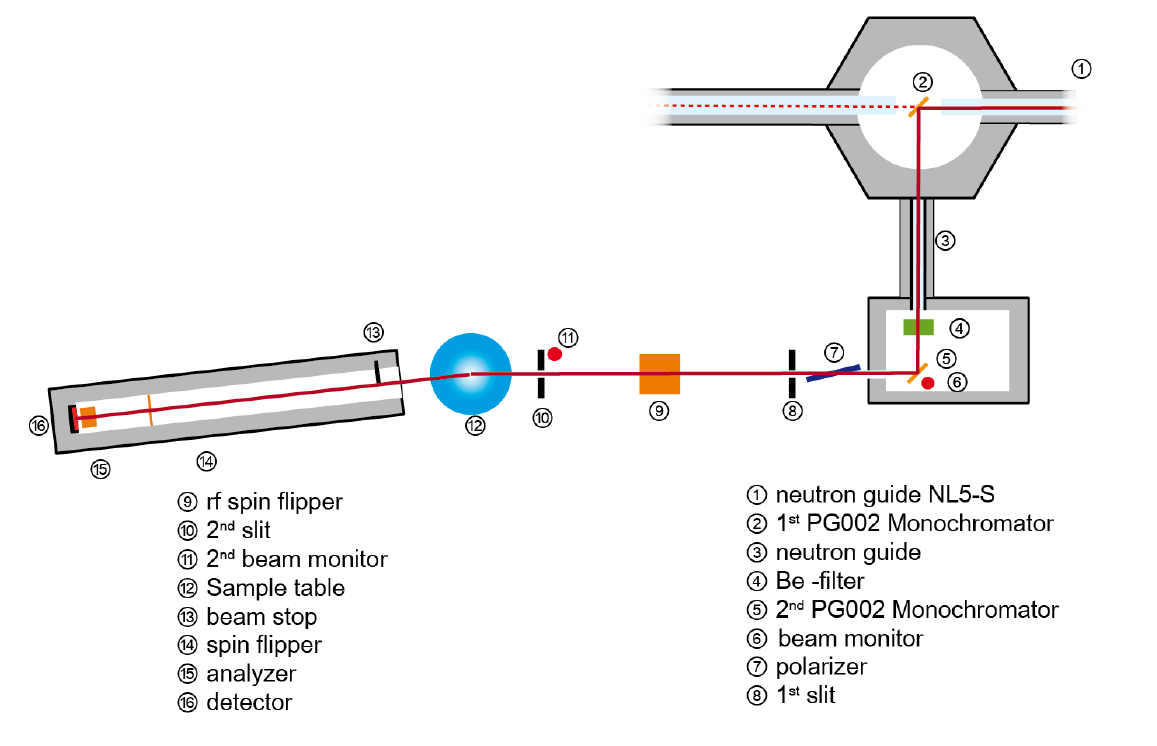
Figure 1: Schematic layout of